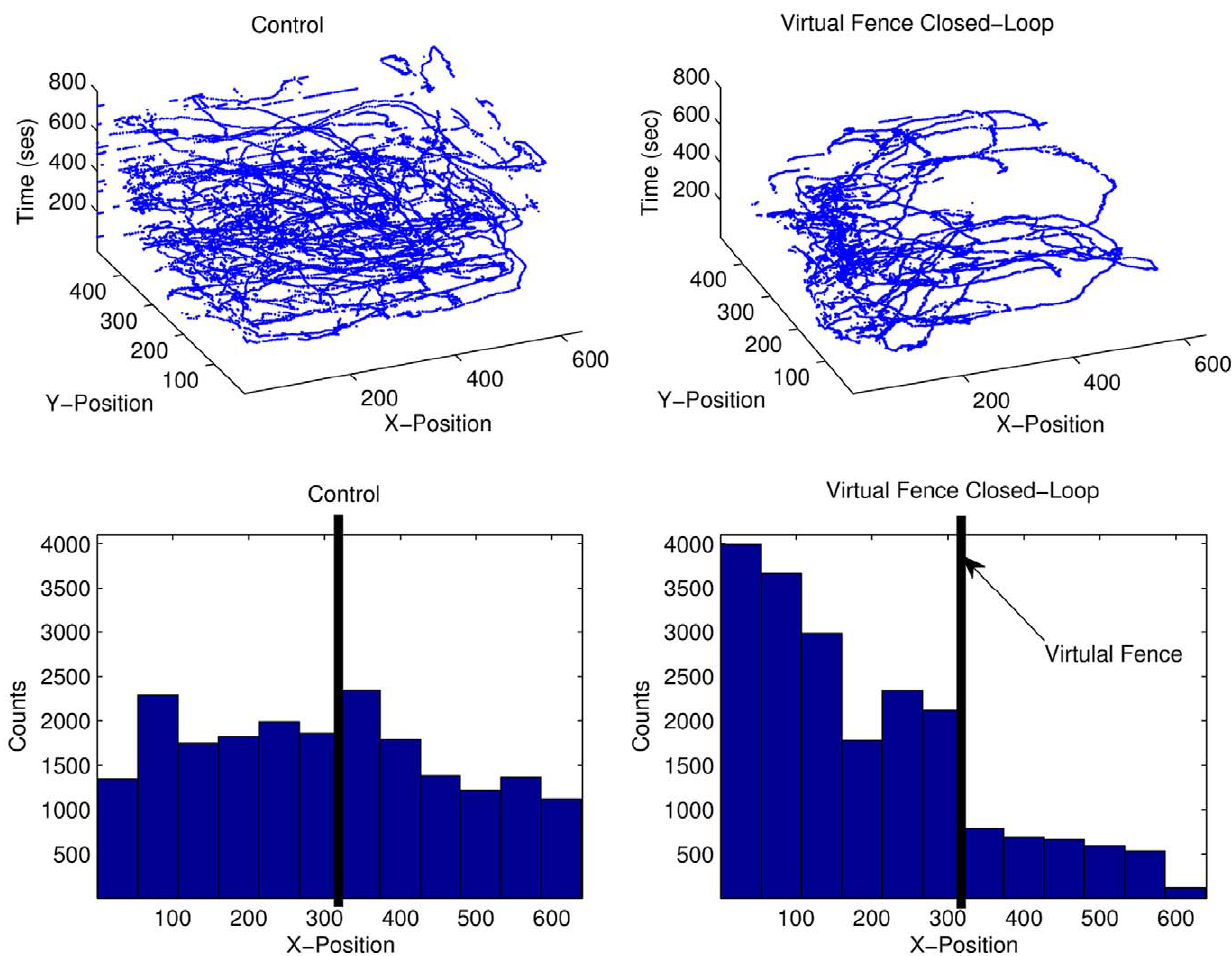
Figure 7. Analysis of the fish position tracking. In the control experiment, the fish explored the tank without a preferred position (left panels). Once the virtual fence closed-loop stimulation started, the fish stayed mainly on the left part of the tank where no stimulation was received (right panels). Note the abrupt change in the histogram at pixel 300 in the horizontal axis of the camera, which corresponds to the position of the virtual